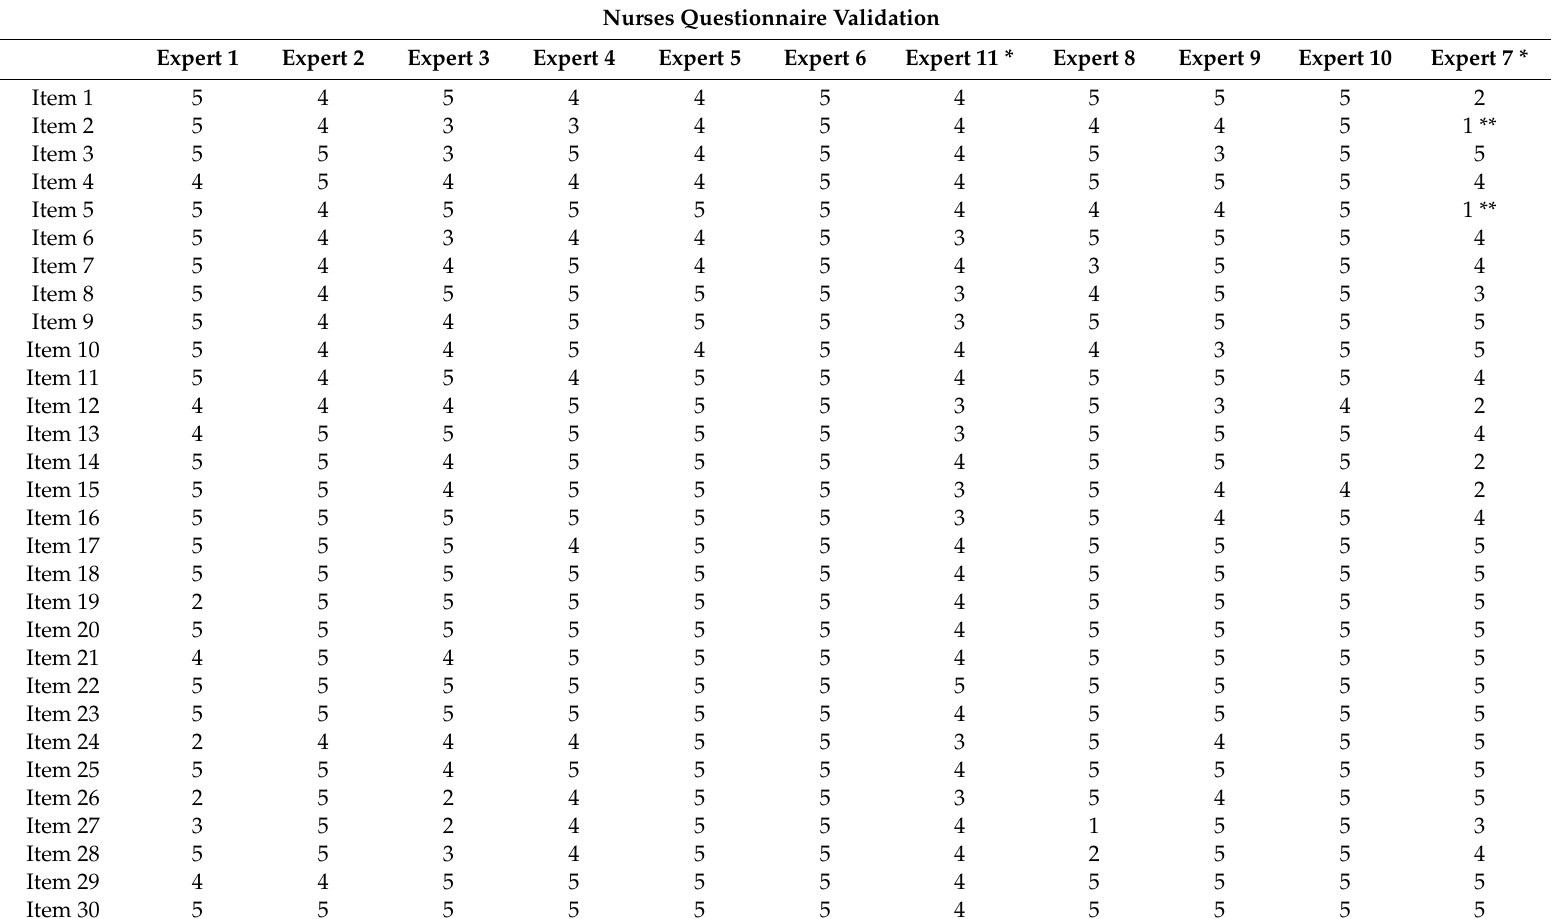
Table 5. Values o ff ered by the nurses’ experts in all questionnaire items for the